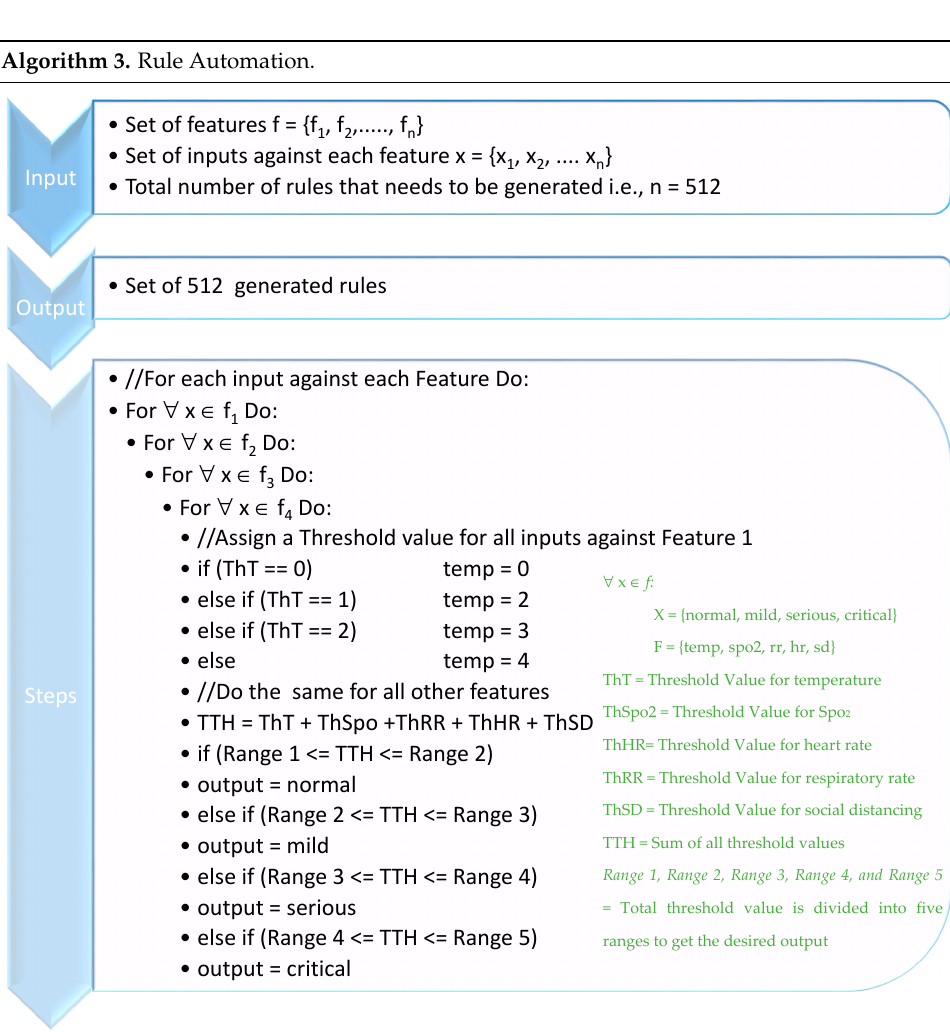
Algorithm 3. Rule Algorithm 3. Rule Automation.